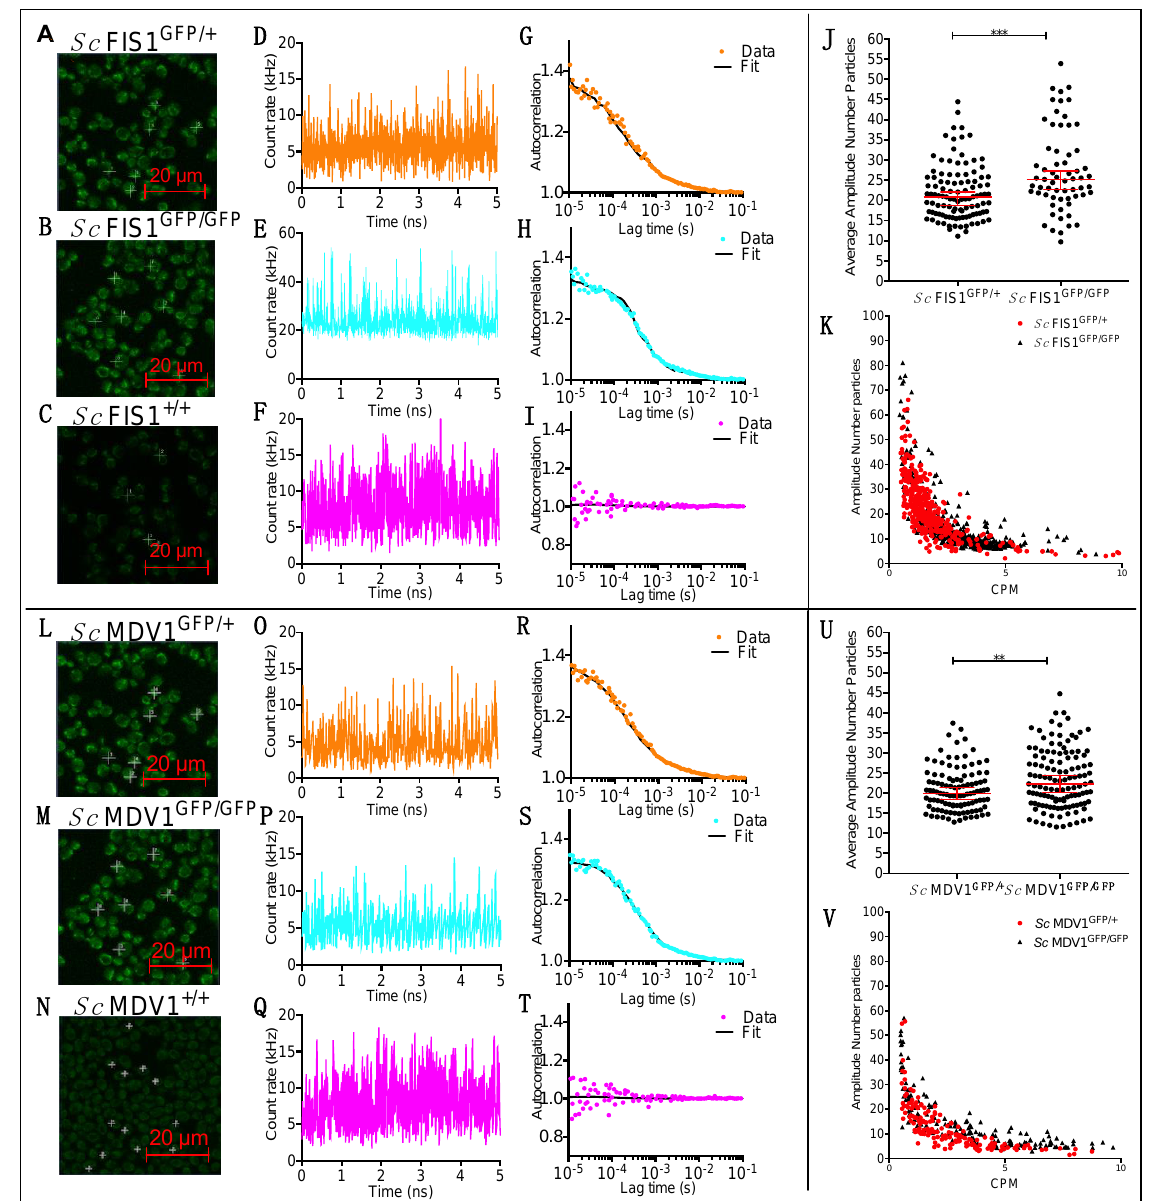
Figure 1. Quantification of Fis1p-GFP and Mdv1p-GFP heterogeneity in living yeast cells. Cells of Sc FIS1 GFP/+ , Sc FIS1 GFP/GFP and Sc FIS1 +/+ were imaged under laser excitation at 488 nm at positions indicated by the crosses ( A – C ). Fluorescence fluctuation traces (fluorescent count in kHz) were obtained over a 5 s period by FCS measurements performed on mitochondrial locations of exponentially growing Sc FIS1 GFP/+ ( n = 107) ( D ), Sc FIS1 GFP/GFP ( n = 63) ( E ) and Sc FIS1 +/+ ( n = 84) ( F ) cells. Correlation analysis showed positive autocorrelation of Fis1p-GFP in Sc FIS1 GFP/+ ( G ) and Sc FIS1 GFP/GFP ( H ) cells and gave no amplitude for the GFP-free Sc FIS1 +/+ control cells ( I ). Scatter plots of mitochondrial Fis1p-GFP concentrations calculated by FCS measurements taken in individual Sc FIS1 GFP/+ ( n = 107) and Sc FIS1 GFP/GFP ( n = 63) cells ( J ). The CPM protein quantification values are negatively and linearly correlated with the amplitude for both cell types ( K ), indicating no fluorescence artefacts ( Sc FIS1 GFP/+ , R 2 = 0.41 and Sc FIS1 GFP/GFP , R 2 = 0.42). Cells of Sc MDV1 GFP/+ , Sc MDV1 GFP/GFP and Sc MDV1 +/+ were imaged under laser excitation at 488 nm at positions indicated by the crosses ( L – N ). Fluorescence fluctuation traces (fluorescent count in kHz) were obtained over a 5 s period by FCS measurements performed on mitochondrial locations of exponentially growing Sc MDV1 GFP/+ ( n = 108) ( O ), Sc MDV1 GFP/GFP ( n = 124) ( P ) and Sc MDV1 +/+ ( n = 84) ( Q ) cells. Correlation analysis showed positive autocorrelation of Mdv1p-GFP in Sc MDV1 GFP/+ ( R ) and Sc MDV1 GFP/GFP ( S ) cells and gave no amplitude for the GFP-free Sc MDV1 +/+ control cells ( T ). Scatter plots of